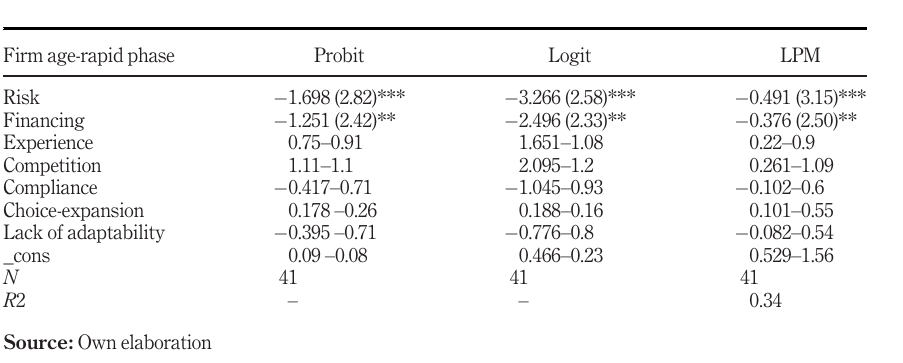
Table 7. Marginal effects